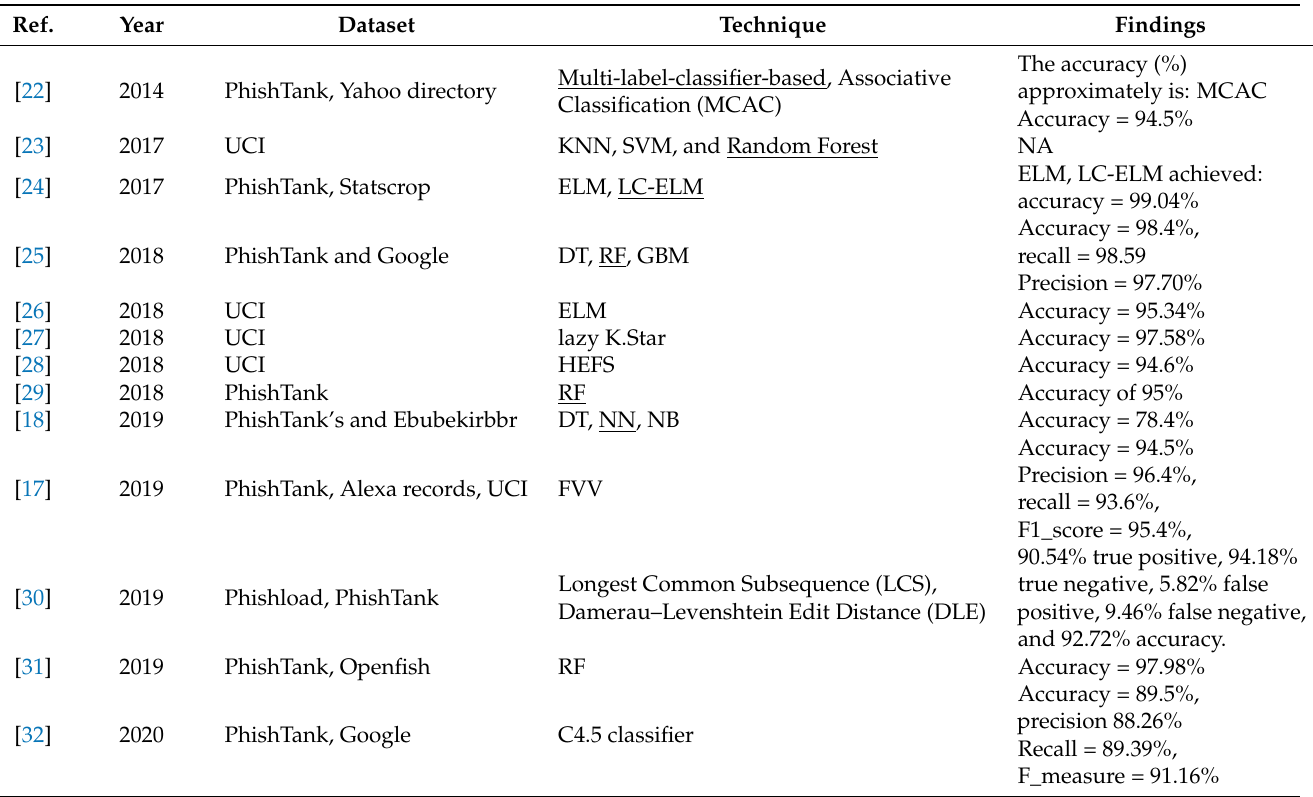
Table 2. Summary of the studies mentioned in the literature